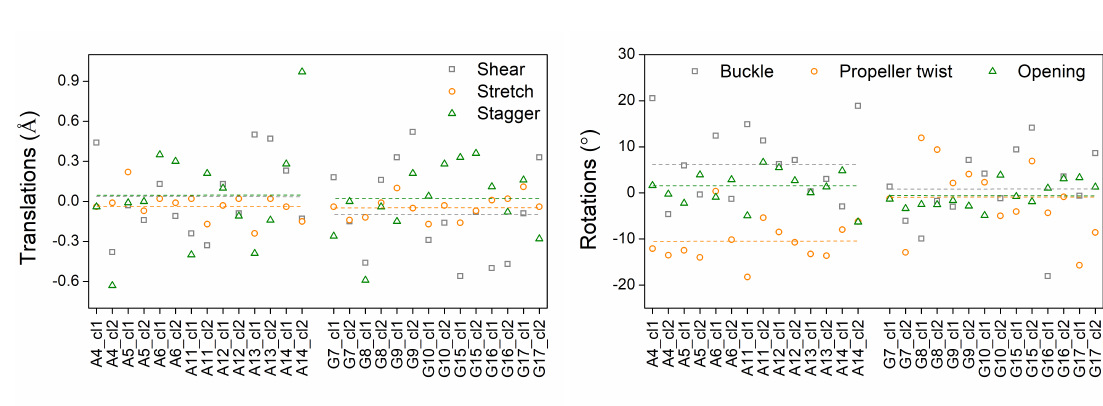
Figure 2. Translation (shear, stretch, stagger) and rotation (buckle, propeller twist, opening) parameters for all studied monomers. Dashed lines denote the mean value of each